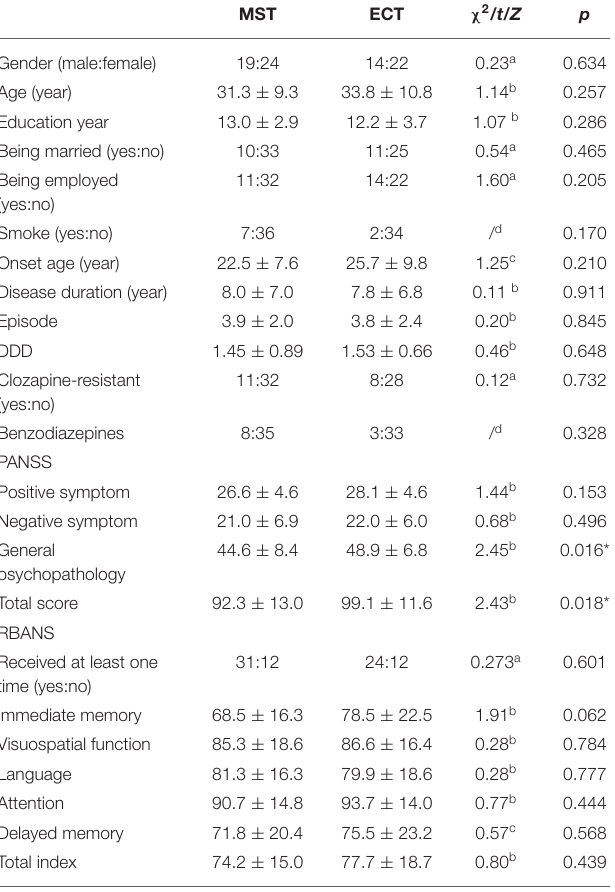
TABLE 1 | Baseline demographic, clinical, and cognitive characteristics of participants.